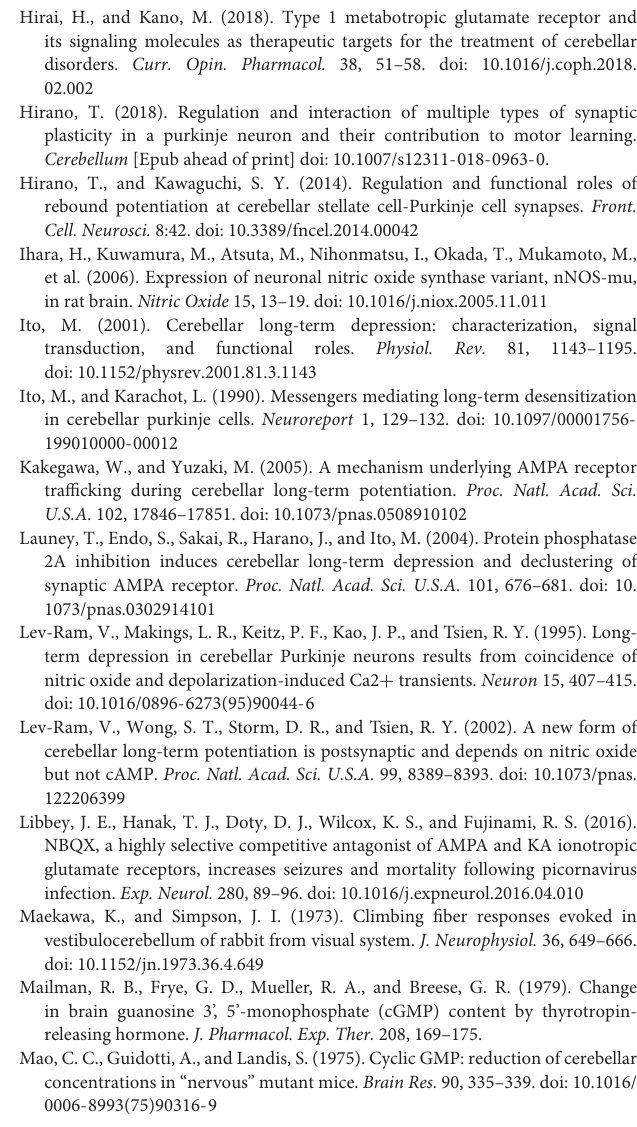
FIGURE S1 | Systemic application of TRH restores rotarod performance of TRH-KO mice to the level comparable to that of their WT littermates. (A) Schema showing the experimental procedure. TRH-KO and WT mice received TRH (6 ml/kg BW, 5 mg/ml) or the same volume of saline intraperitoneally (i.p.). The effects of the treatment were tested 10 min after the injection using the rotarod test. (B) Results of the rotarod test. Mice were subjected to four trials ( n = 9 mice